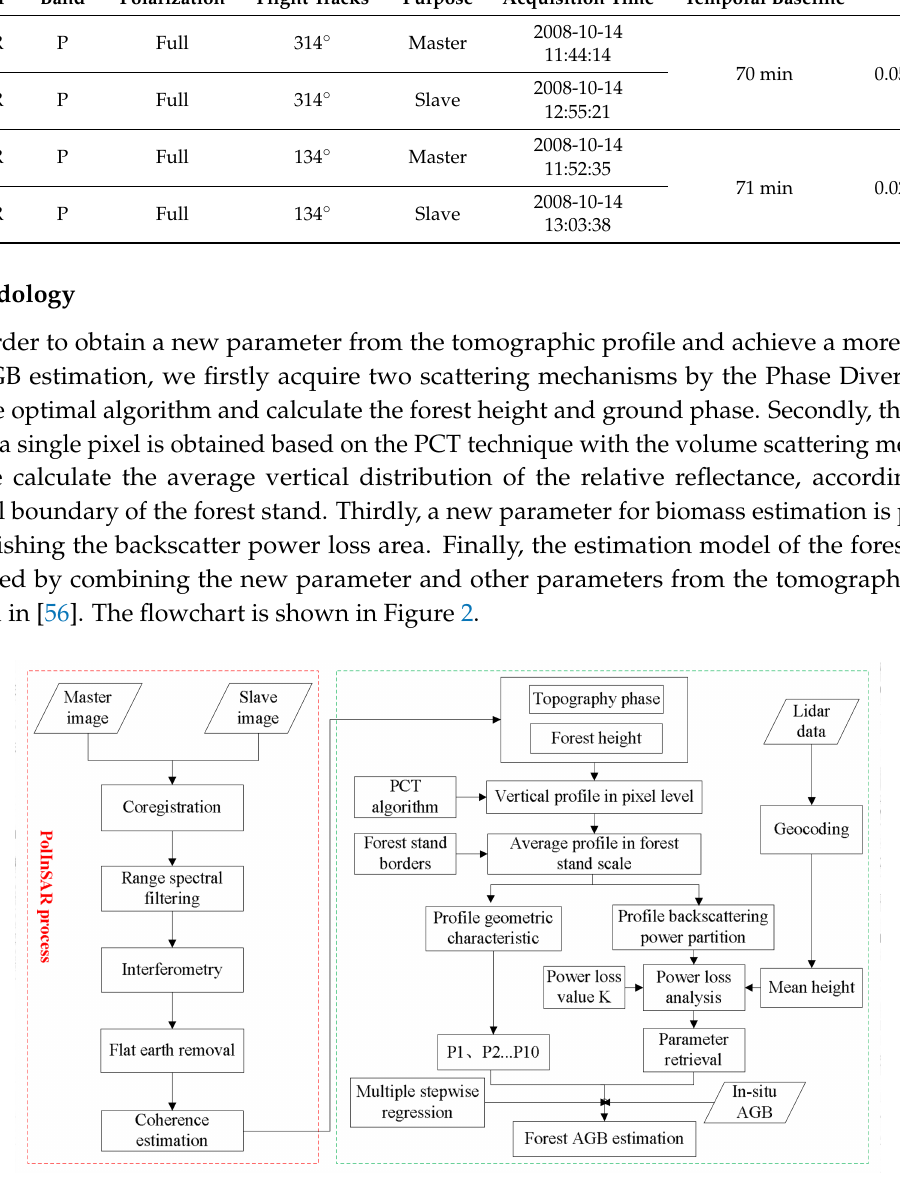
Figure 2. Flowchart of forest AGB estimation. AGB: above ground biomass; PCT: polarization coherence tomography; PolInSAR: Polarimetric SAR interferometry; P1–P10: